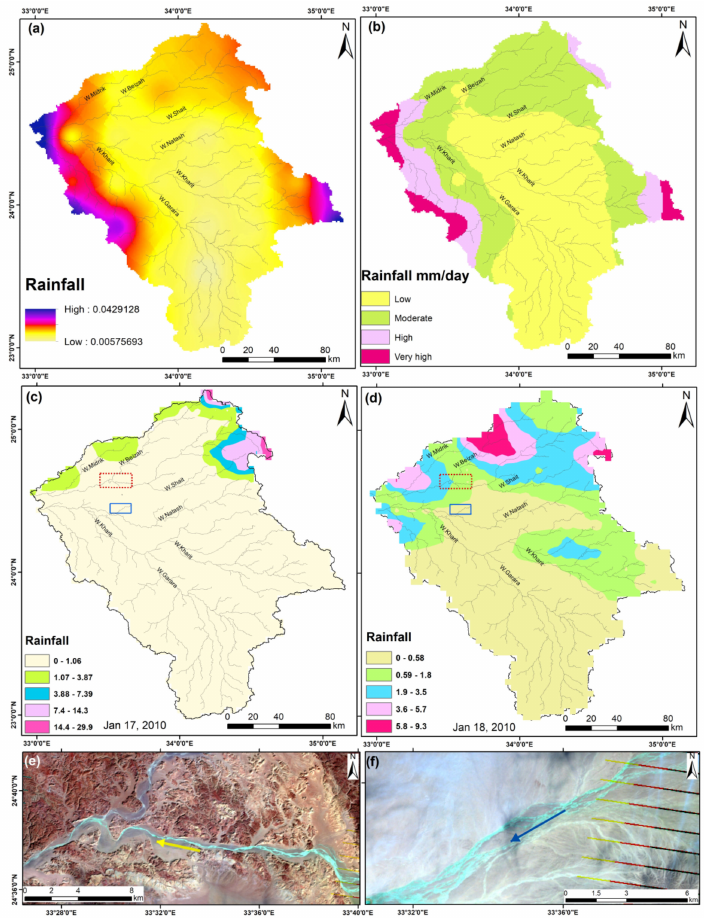
Figure 11. ( a ) Average rainfall (years 1997–2015) in the study area; ( b ) rainfall density map; ( c , d ) rainfall storm on 17 to 18 January 2010; ( e , f ) evidence of surface water signature of the downstream of W. Shait, as revealed from Landsat-7, acquired on 25 January